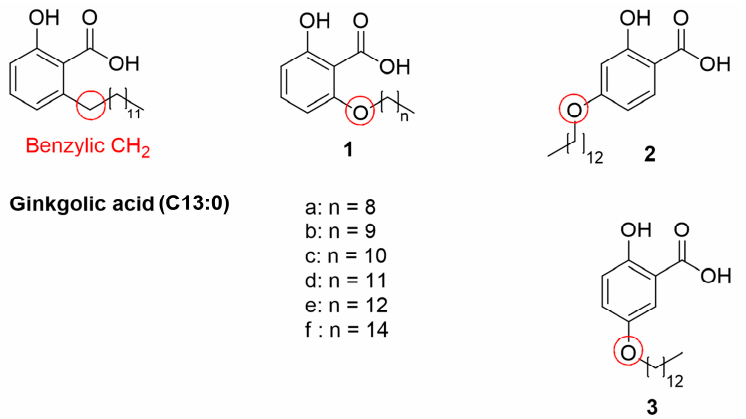
Figure 1. Structures of GA and alkyloxy salicylic acids.